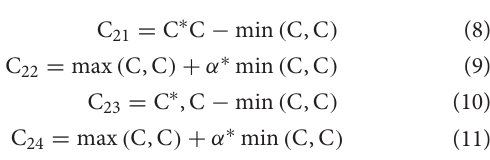
features of the left diagonal and right diagonal are multiplied to obtain the third secondary image weight, C 23 . Likewise, the weight features of the left diagonal and right diagonal are also multiplied to obtain the third secondary image weight C 24